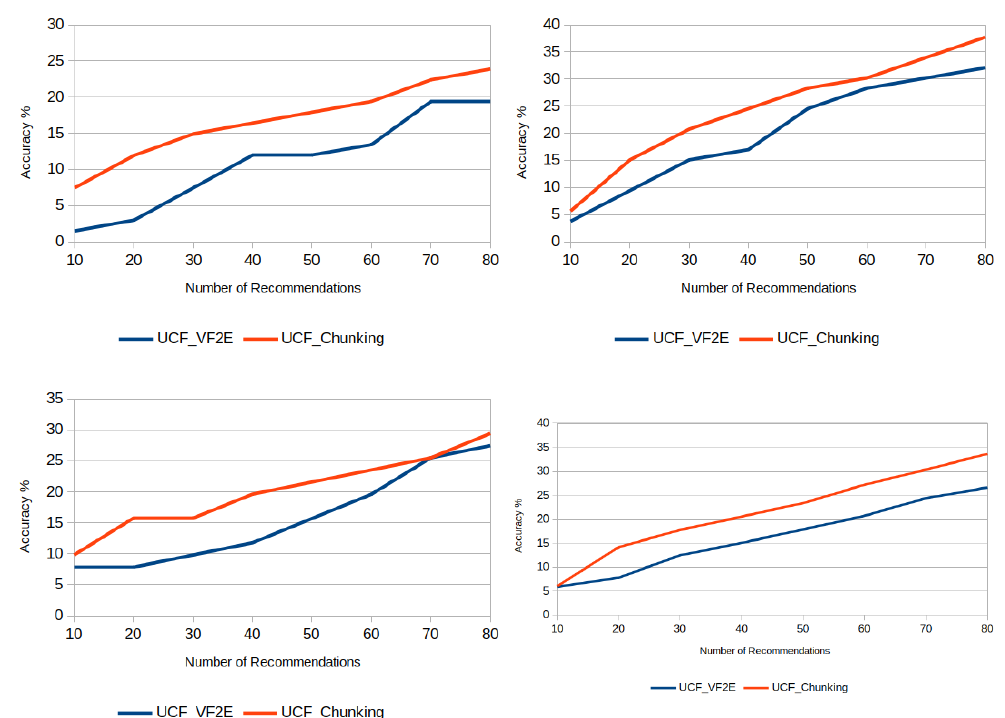
Figure 8. Performance comparison of proposed UCF_Chunking technique with baseline methods (VF2E) for a group of three users in each graph and the average results graph of these groups.